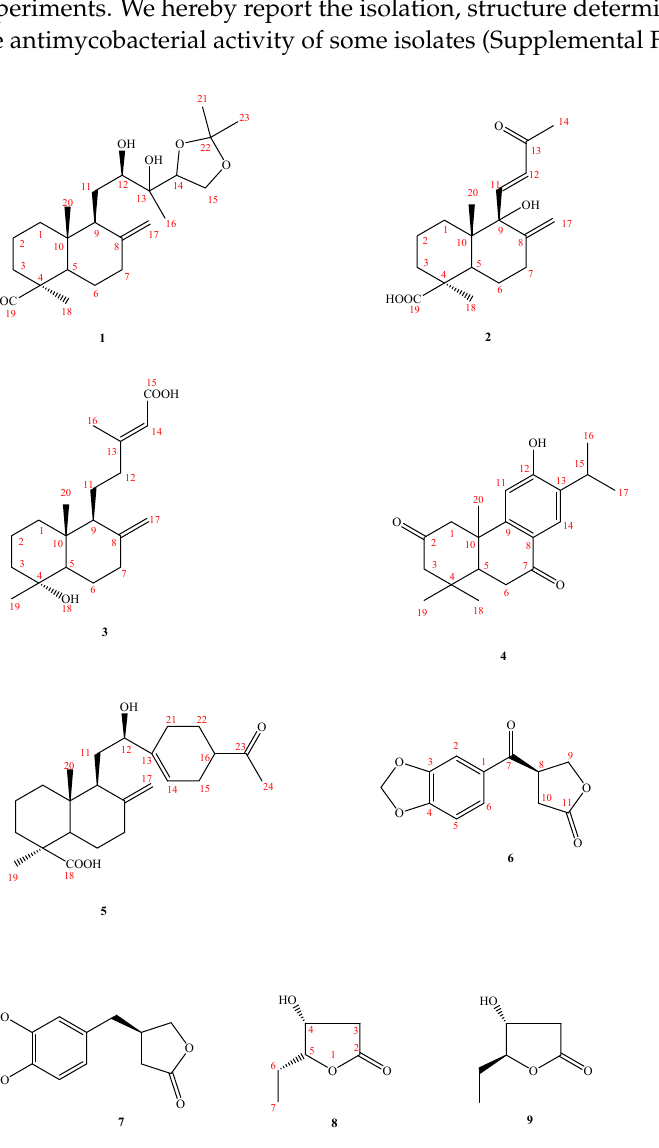
Figure 1. Compounds 1–9 , isolated from Herbidospora yilanensis .